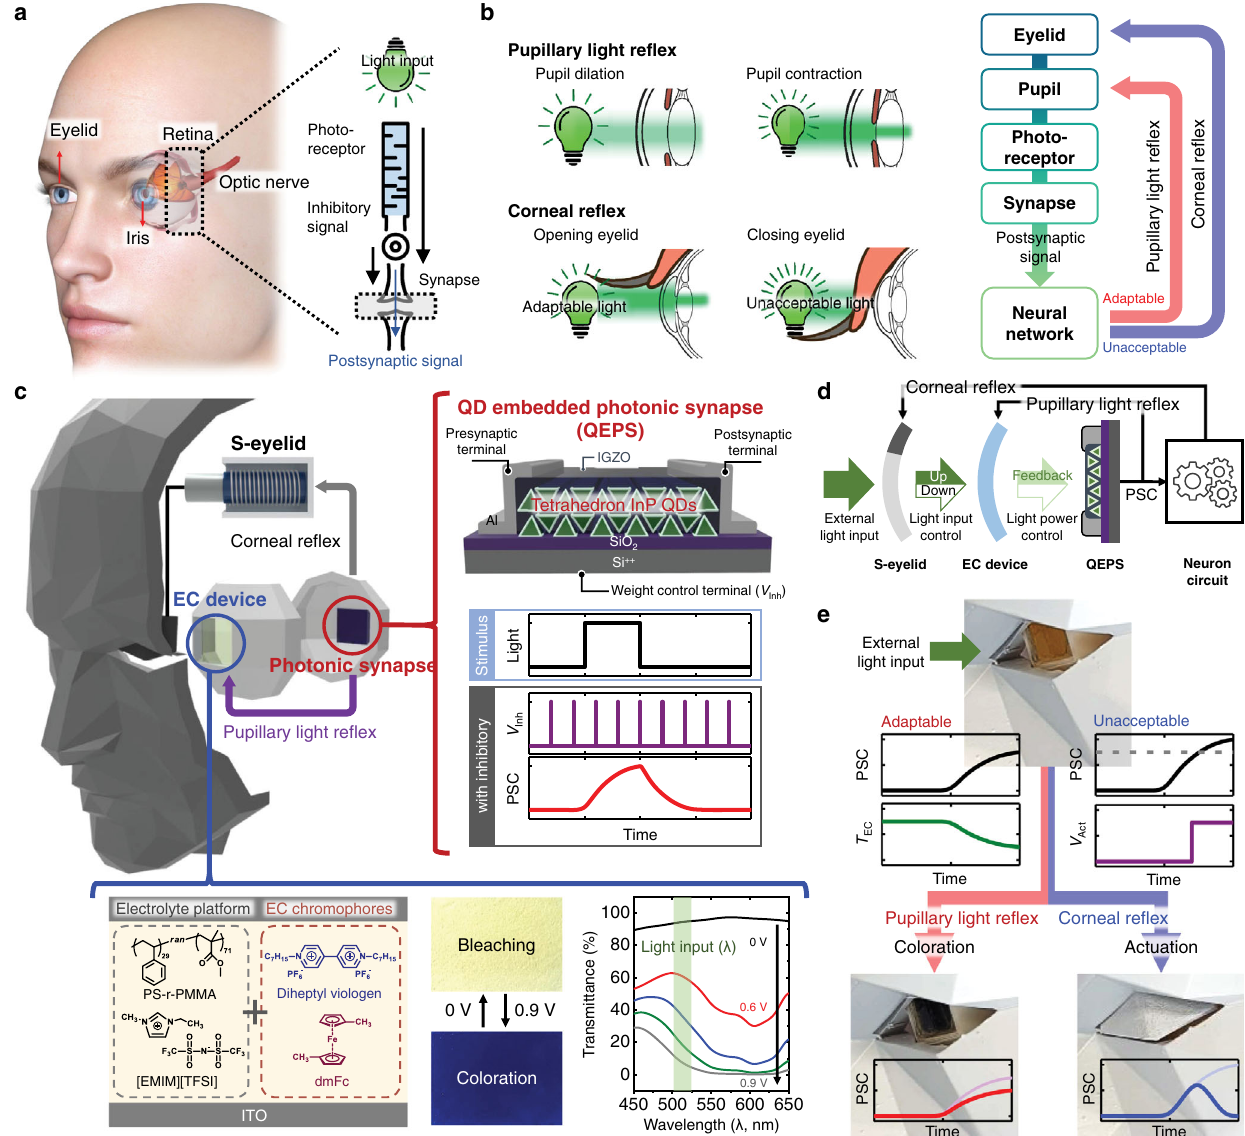
Fig.1|Schematicofabiomimeticocularprosthesisconsistingofpupillarylight re fl ex and corneal re fl ex. Schematic of a concretization of the visualinformation; b regulationofincidentlightilluminanceinabiologicalsystem; c ocularprosthesis